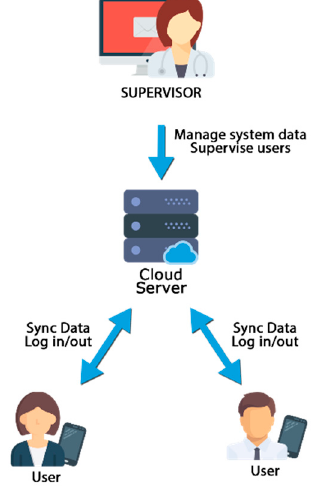
Figure 1. System user overview.